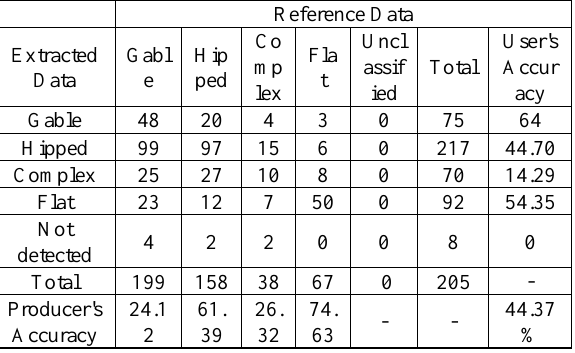
Table 5. Confusion matrix for roof shape classification.